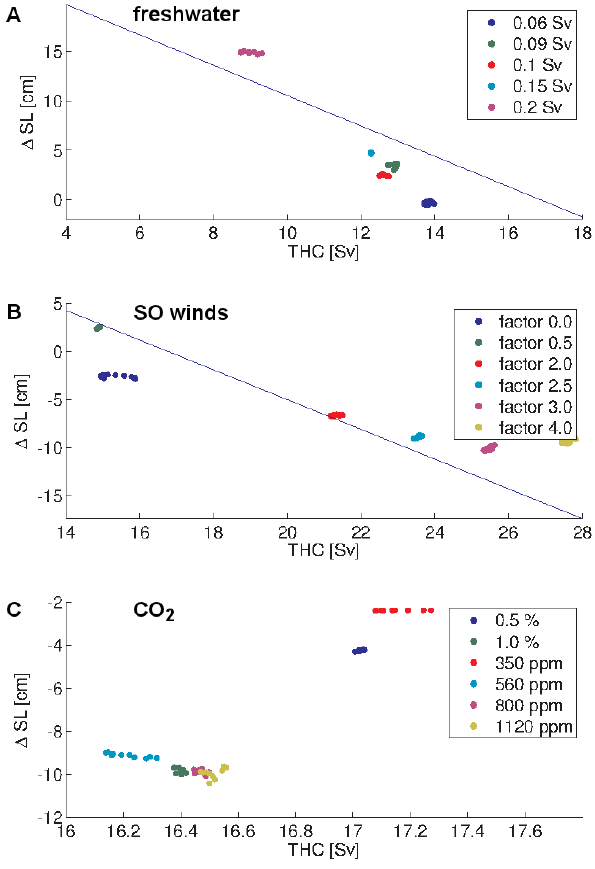
Fig. 6. 1 SL NC after 1000yr for the following forcings: (A) fresh- Fig. 6. ∆SL NC after 1000 yr for the following forcings: (A) freshwater, (B) Southern Ocean winds, (C) CO 2 . water, (B) Southern Ocean winds, (C) CO 2 . The lines in the upper The lines in the upper two panels follow Fig. 3. two panels follow Fig.